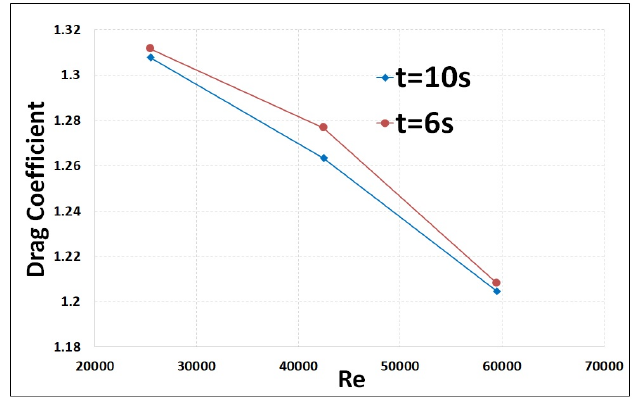
ffi cient with Reynolds numbers for t = 6 s and t = 10 Figure 17. Change in drag coefficient with Reynolds numbers for ( a ) t = 6 s and ( b ) t = 10 s. Figure 17. Change in drag coe